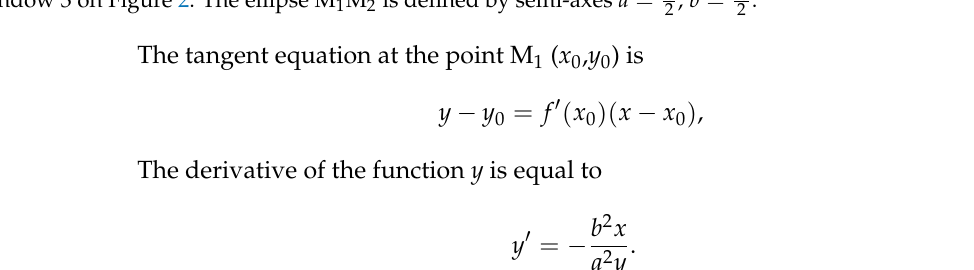
, (cid:1854) = (cid:3029) (cid:3294) . , b = b s . (cid:2870) (cid:2870) 2 2